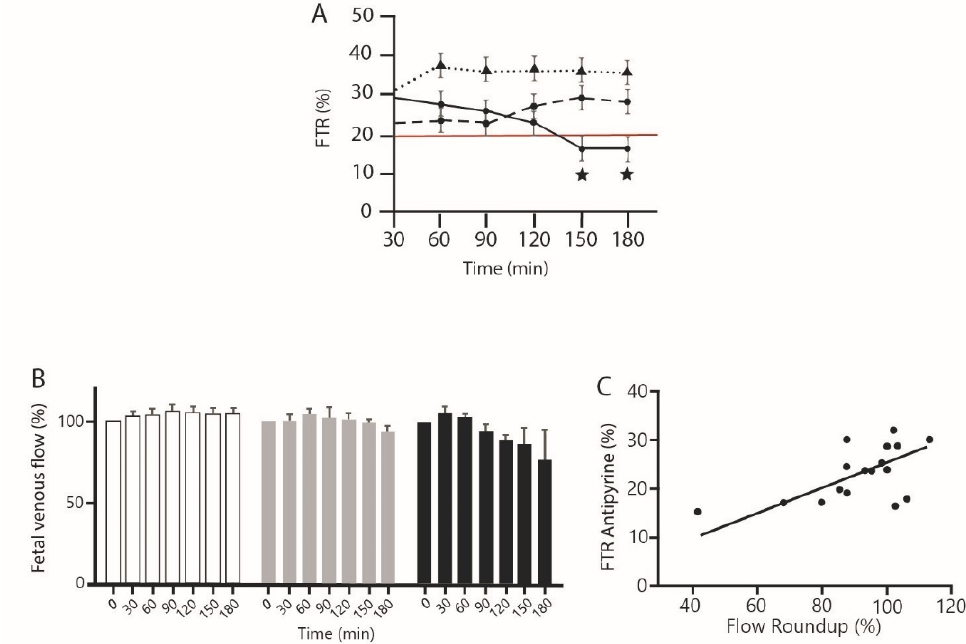
Figure 2. Fetal transfer rate and fetal venous flow of antipyrine in presence of glyphosate alone or with its formulants. ( A ) Effect of 1 ppm G alone or in R compared to antipyrine fetal transfer rate (FTR). ★ Significant differences, for 150 min p < 0.04, for 180 min p < 0.02. Small dots: control, dashed line: G alone, bold curve: R. Red line, minimal normal FTR. ( B ) Effect of 1 ppm G alone or in R on fetal venous flow during placental perfusion. Control is in white bars, grey bars are for G alone, R treatments correspond to black bars. ( C ) Correlation between antipyrine fetal transfer rate and fetal venous flow for R at all times. Values given are raw data. Significant correlation p < 0.0102; r = 0.58.